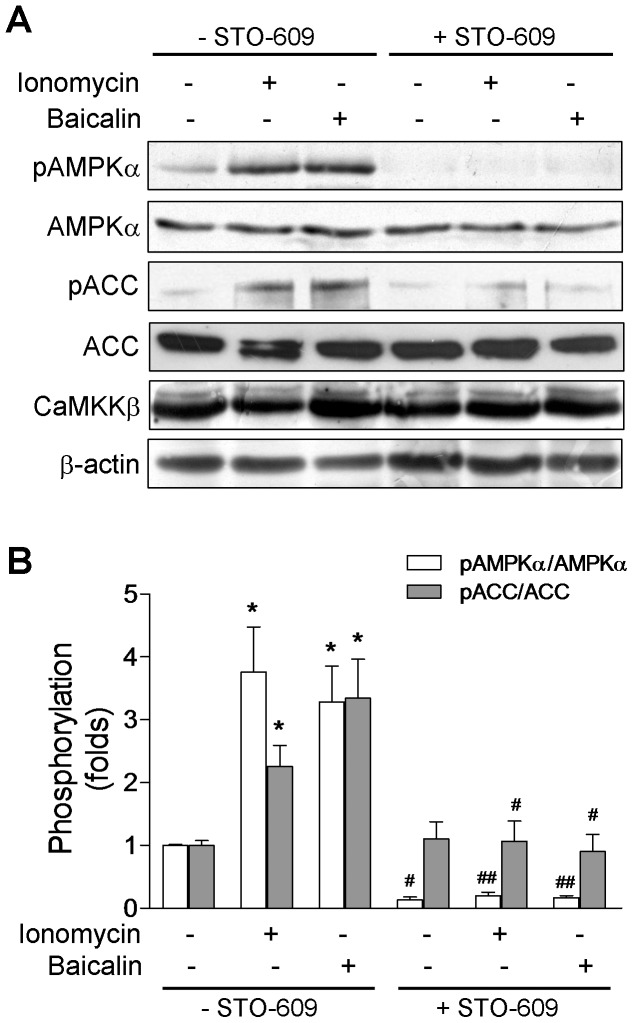
Inhibition of CaMKKβ blocks baicalin-induced AMPKα and ACC phosphorylation in HeLa cells.(A) Representative Western blots showing the effect of the CaMKKβ inhibitor STO-609 on baicalin-induced phosphorylation of AMPKα at Thr-172 (pAMPKα) and phosphorylation of ACC at Ser-79 (pACC) as well as total AMPKα, ACC and CaMKKβ protein expression. Cells were treated with 5 µM baicalin for 1 hr or 1 µM ionomycin for 5 min in the absence or presence of 10 µg/mL STO-609. (B) Histogram represents the fold change in the pAMPKα/AMPKα or pACC/ACC ratio from at least three independent experiments. * p<0.05 compared to respective untreated control; #
p<0.05 and ##
p<0.01 compared to respective treatment group in the absence of STO-609.